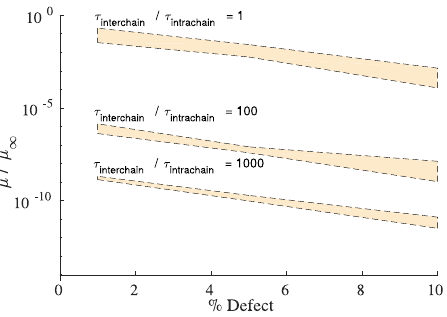
Fig. 5 A comprehensive view of the effect of defect density and inter/intra-chain hopping ratio on effective mobility. Each data point represents statistically averaged results across 500 model morphologies. The fi gure represents ~15,000